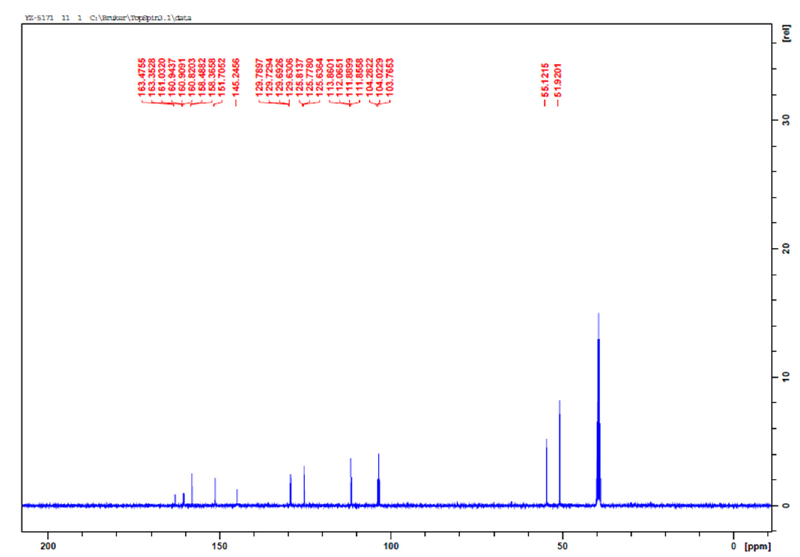
Figure A4: 13 C NMR spectra of compound